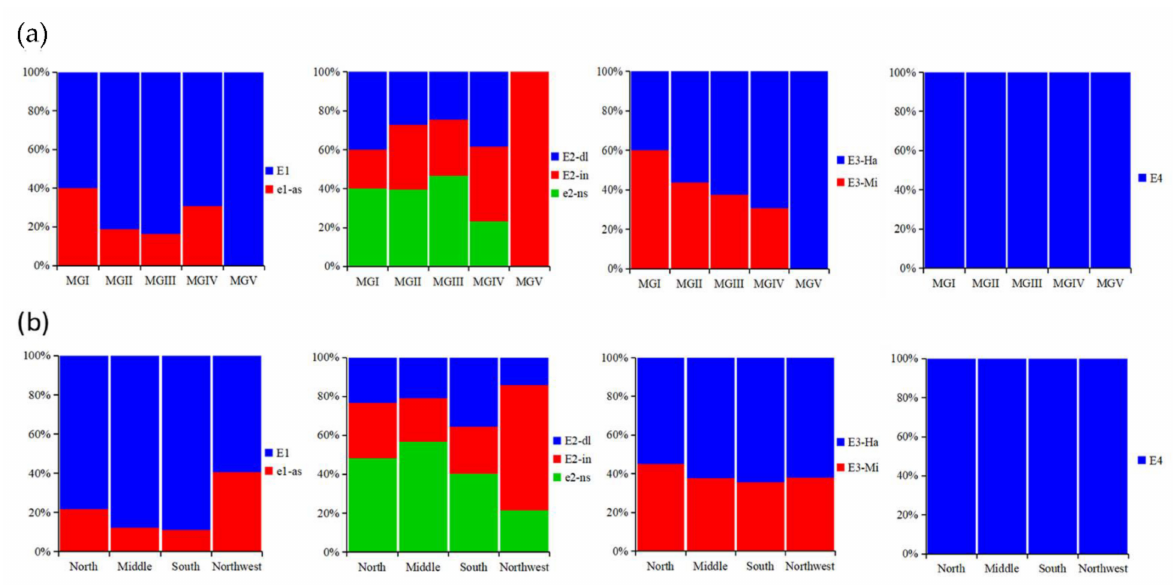
Figure 2. Distribution of E1 – E4 alleles among different ( a ) maturity groups (MGs) and ( b ) sub-regions. Columns with different colors represent different E